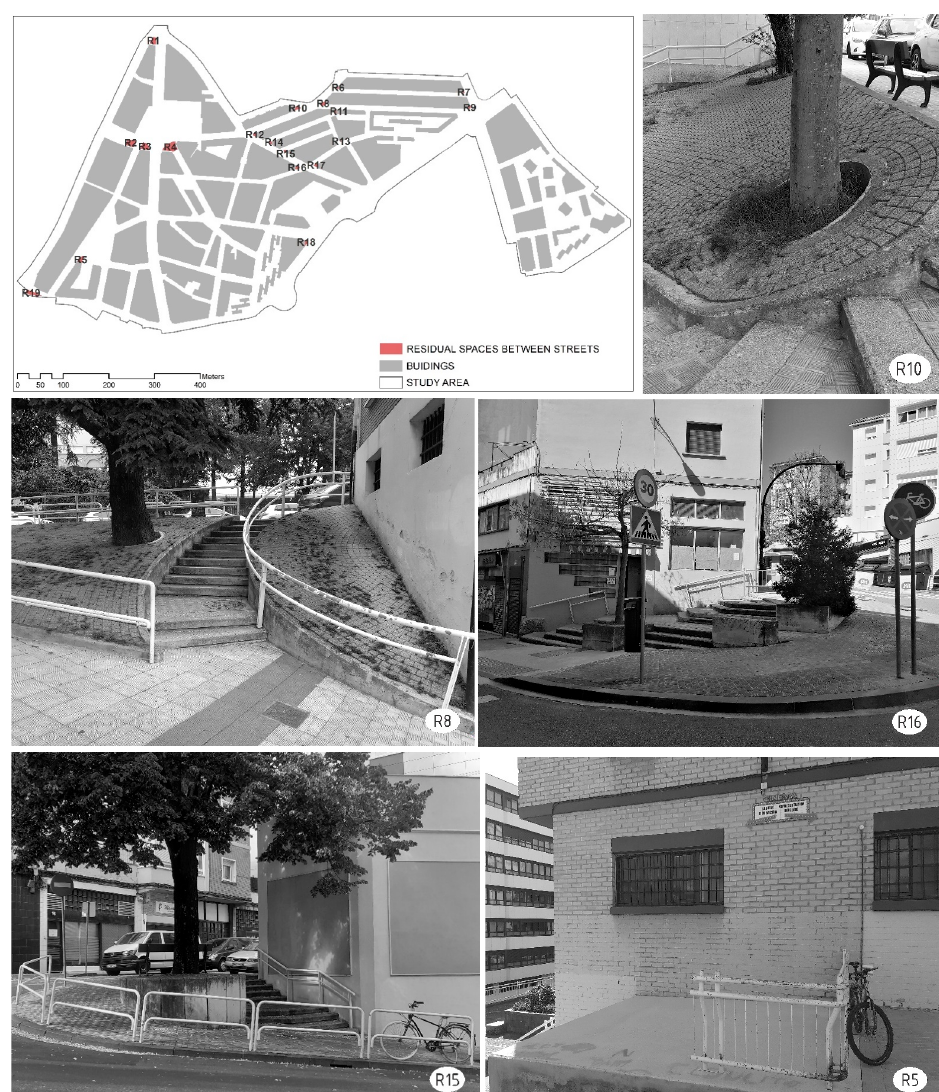
Figure 14. Residual spaces between streets.